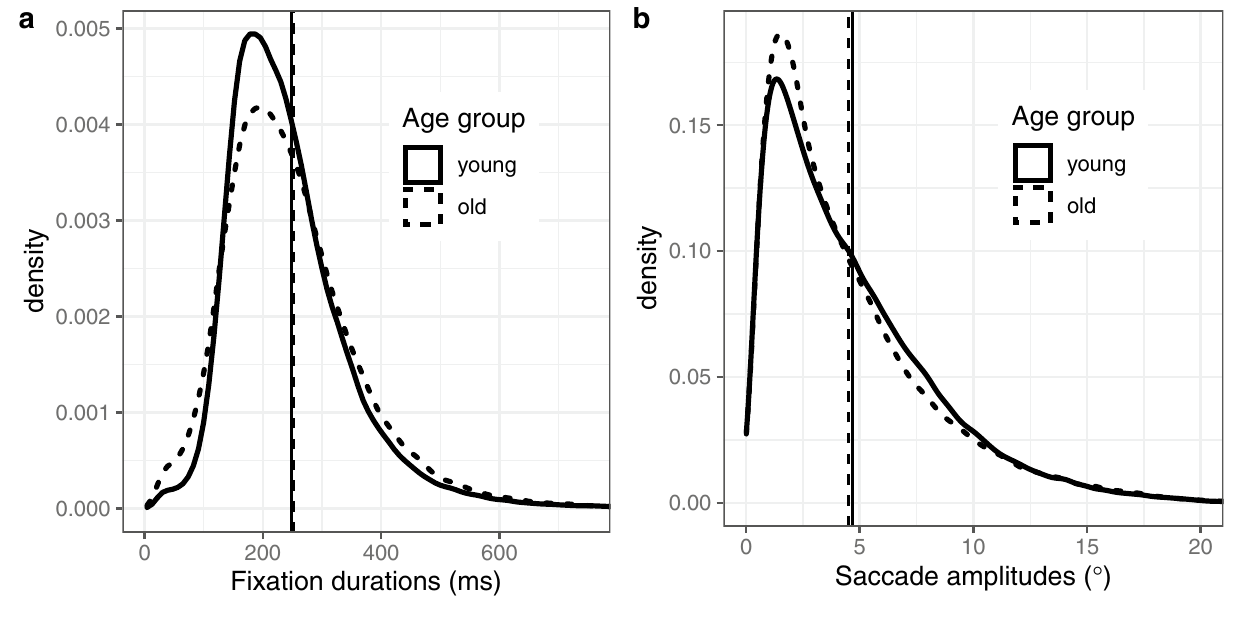
Figure 2. Basic eye-movement measures for young and older adults. Distributions of fixation durations ( a ) and saccade amplitudes ( b ) are shown. The vertical lines represent the corresponding means.